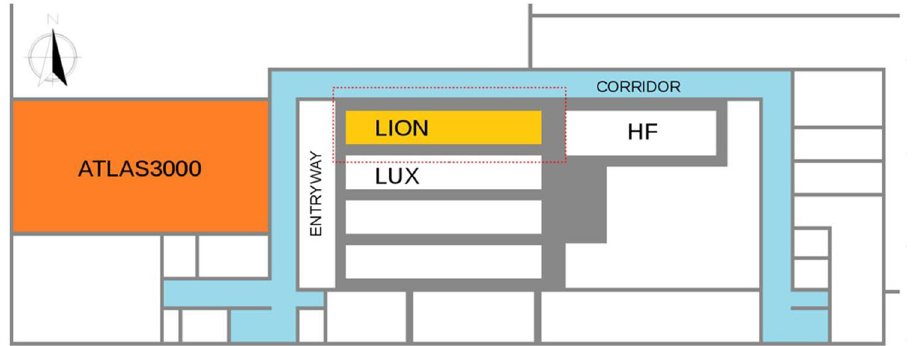
Figure 1. Top-view drawing of the CALA building. In orange the room hosting ATLAS3000 laser, in yellow the LION cave and in light-blue the corridor surrounding the facilities’ caves. Names of rooms adjacent to the LION